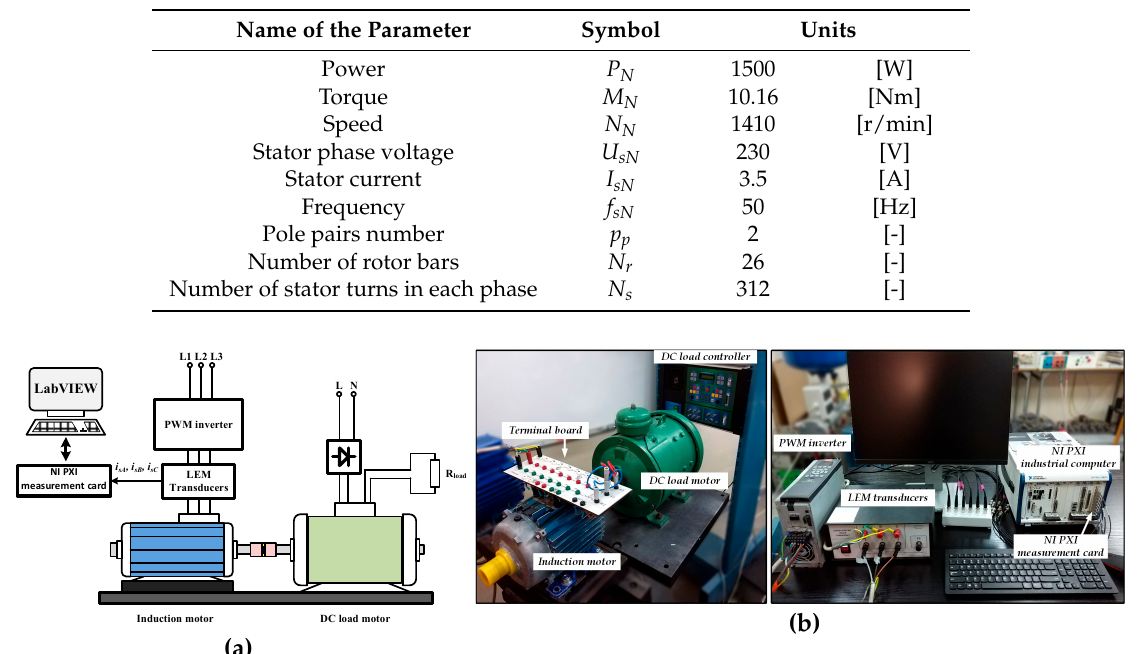
Figure 4. Illustration of the physical modelling of stator and rotor fault: ( a ) connection of the stator winding for inter-turn short-circuit modelling; ( b ) broken bars modelling in squirrel-cage rotor. The tests were carried out for various types of stator or rotor winding damage as well as mixed defects. During the tests, special attention was focused on the changing operating conditions of the machine, in order to ensure high efficiency of fault detection regardless of the load torque and reference speed of the drive system. The conducted research was limited to examining the impact of the following electrical faults of the driving motor: • 0 ÷ 5 shorted turns of one stator phase that constituted 1.6% of stator turns in phase A, • 0 ÷ 2 damaged rotor cage bars that constituted 7.7% of rotor bars. The stator winding has been specially prepared so that you can make a short circuit of the proper number of turns in each phase of the stator. A corresponding group of coils was led out to the terminal board, and the short-circuit was physically modelled through a metallic connection. The research presents the impact of a fault in a single phase of the motor winding (Figure 4a). Rotor damage, in the form of broken bars, was modelled by preparing rotors with pre-drilled windings. In addition, the resulting holes were sealed to reduce the impact of the rotor imbalance (Figure 4b). On the basis of the conducted tests, the symptoms of rotor and stator defects of the induction motor were selected in order to start the process of Kohonen networks’ learning. The self-organizing maps were implemented in the LabVIEW environment of National Instruments using Matlab software [45]. 4.2. Results of Stator and Rotor Fault Extraction